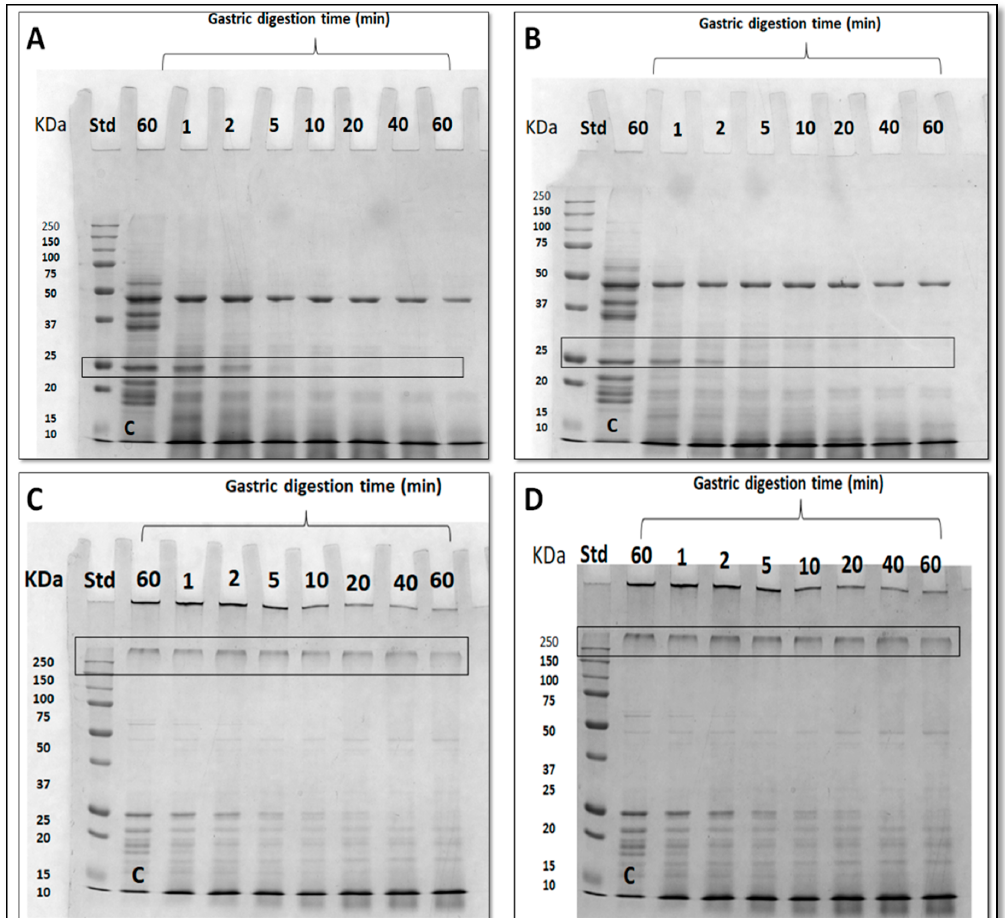
Figure 8. Sodium dodecyl sulfate polyacrylamide gel electrophoresis (SDS-PAGE) of fried kobbah digested by in vitro gastric digestion (IVD) experiments. (Panel A ): kobbah dipped in water (control); (Panel B ): kobbah dipped in grass pea flour (GPF); (Panel C ): kobbah dipped in GPF + mesoporous silica nanoparticles (MSN); (Panel D ): kobbah dipped in GPF + transglutaminase (TGase 33 U / g); (Panel E ): kobbah dipped in GPF + MSN + TGase (33 U / g). The bands in the rectangle are those chosen for densitometry analysis. C is control sample incubated with simulated gastric fluid (SGF) prepared without pepsin. Std, Molecular mass standards,